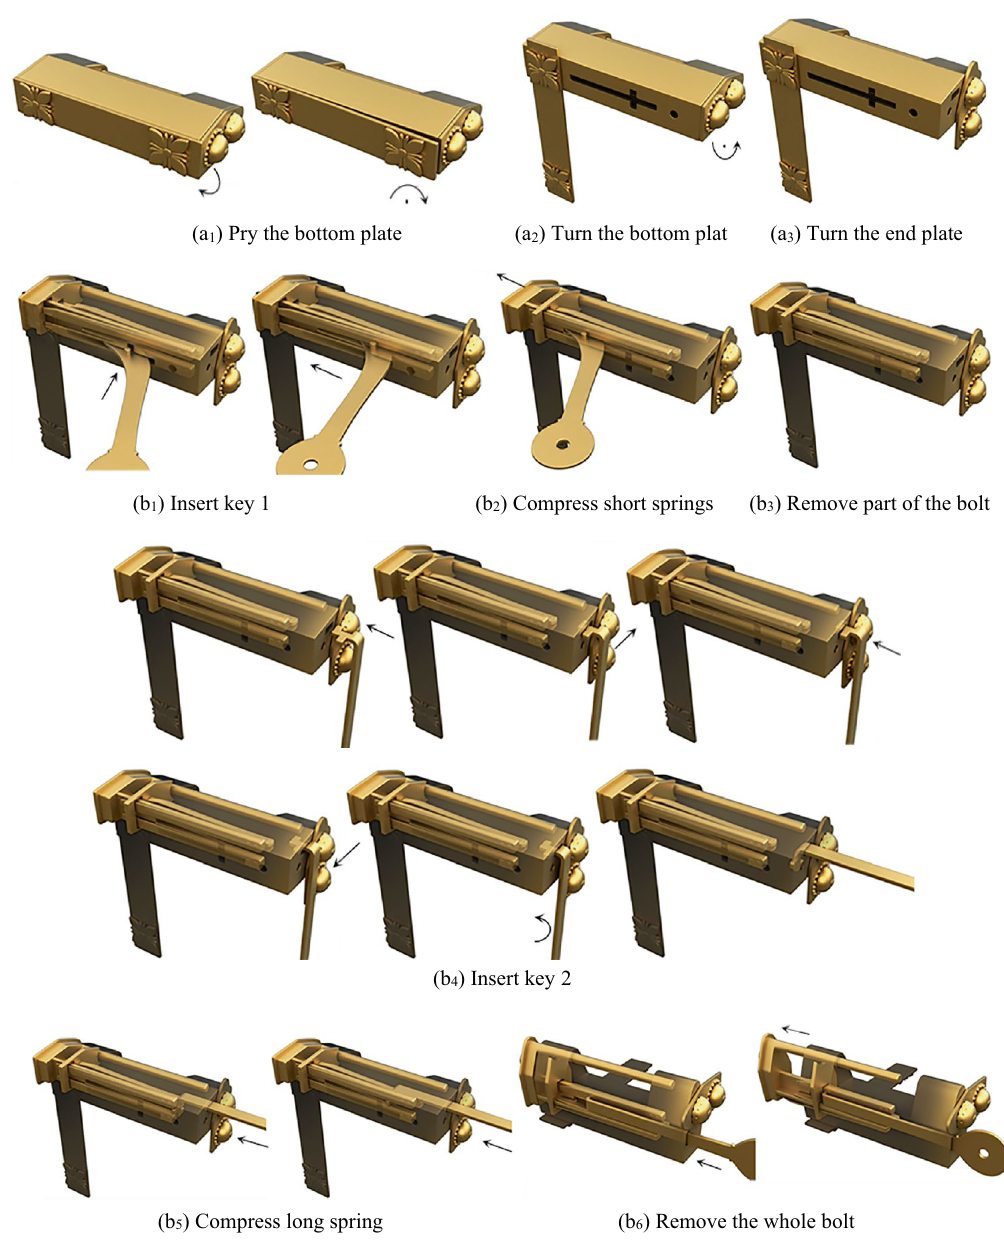
Figure 17. Simulation of prying bottom-plate